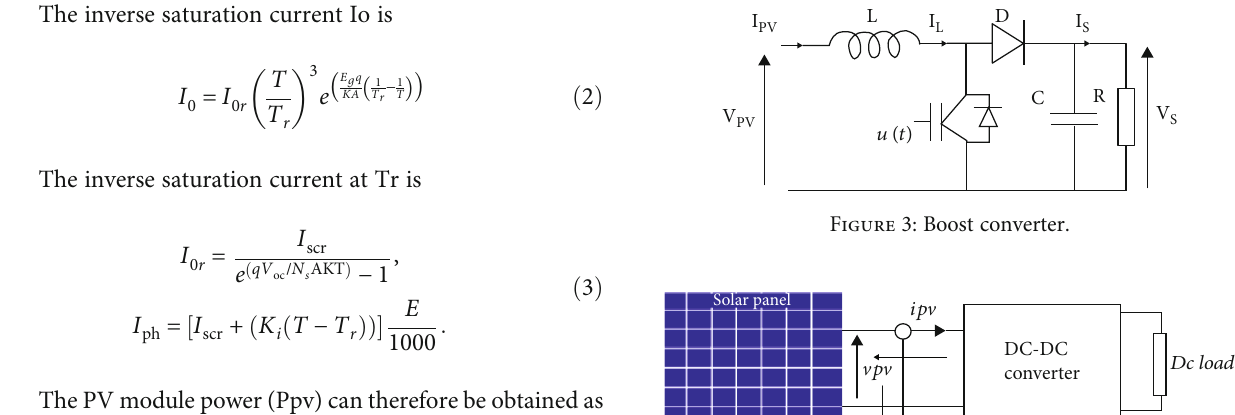
Figure 4: Sliding mode control.